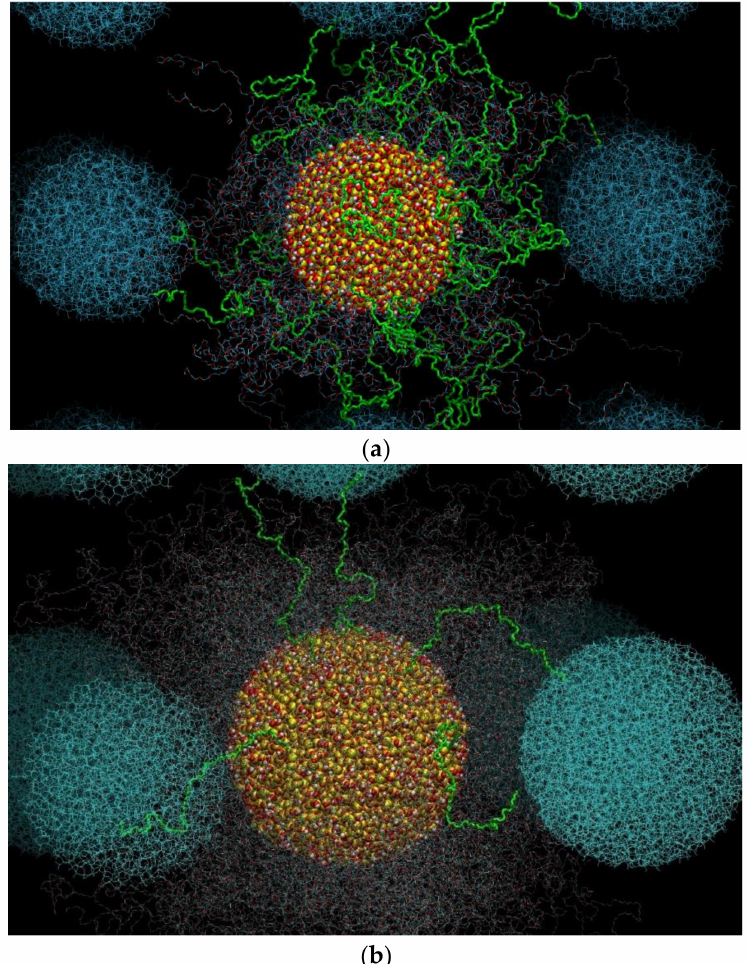
Figure 9. Typical atomistic snapshots of the nanoparticle network formed in: ( a ) the d5_v15_PEG, and ( b ) the d9_v15_PEG nanocomposite ( T = 413 K and p = 1 atm). With yellow, red, and white we show the silica atoms. With blue we indicate images of the silica nanoparticle in neighboring cells. Non-bridging chains are shown in red, white, and cyan, and bridging ones in